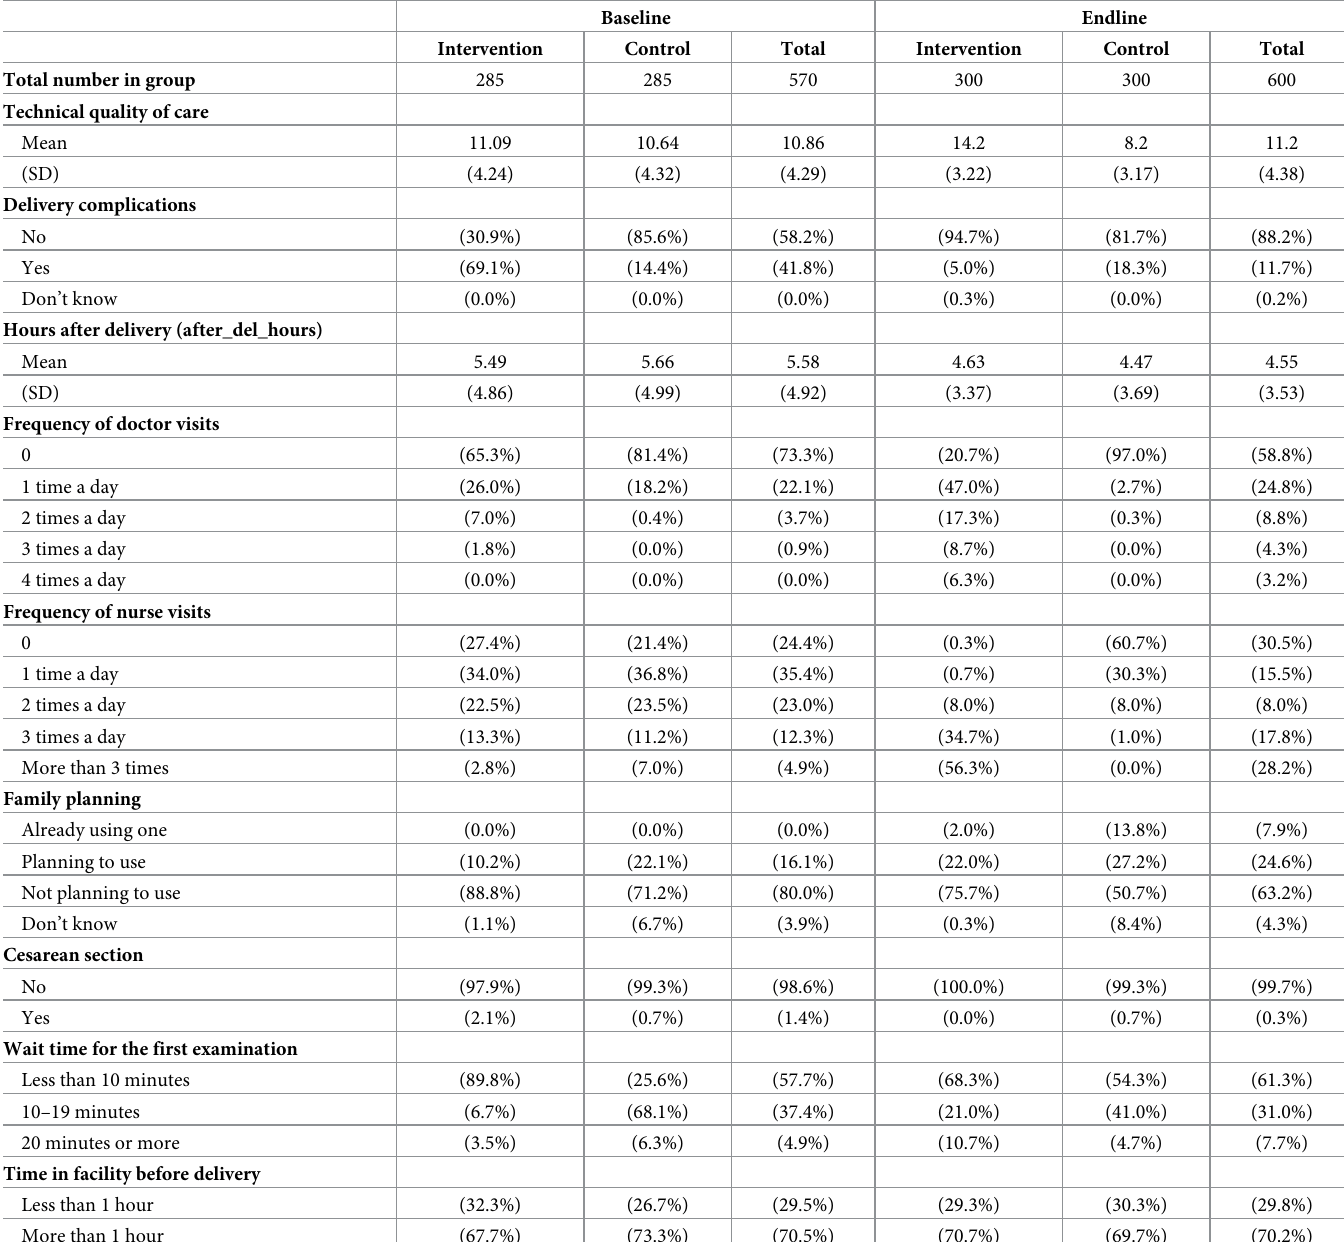
Table 4. Impact of intervention on other health